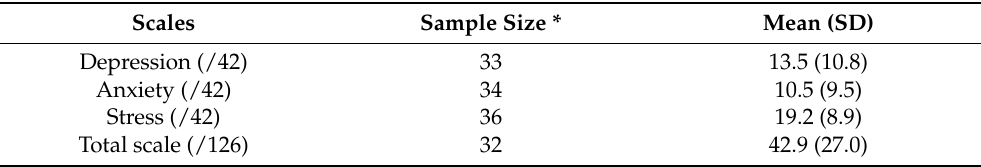
Table 2. Depression, Anxiety and Stress Scale (DASS-21) scores of parents of children with disabilities from the province of Quebec (Canada) during the COVID-19